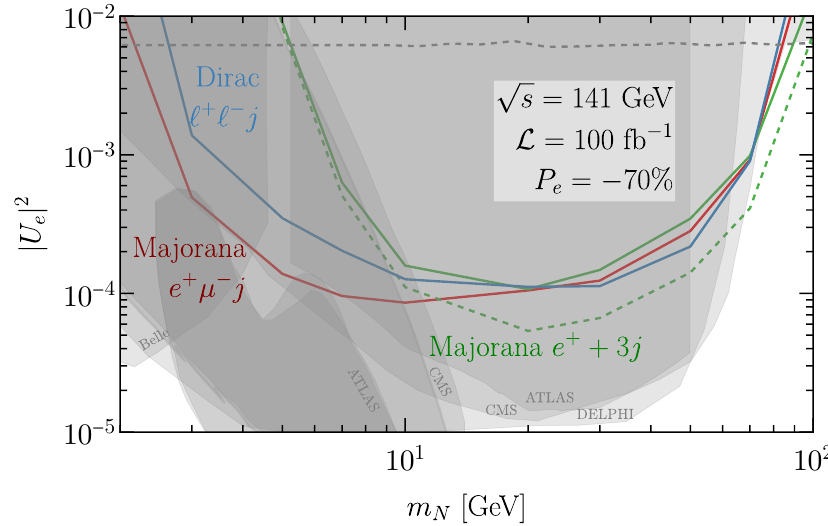
Figure 9 . The expected 95 % C.L. exclusion limits from prompt searches at the EIC with √ s = 141 GeV and 100 fb − 1 of integrated luminosity for HNLs (colored lines), compared with the existing bounds from direct searches [75–80] (gray shaded regions) and indirect precision elec- troweak constraints [81] (horizontal dashed line). The solid (dashed) green line indicates the sensitivity of the prompt Majorana HNL decay N → e + + 3 j , with a misidentification rate assumed as 0.1%